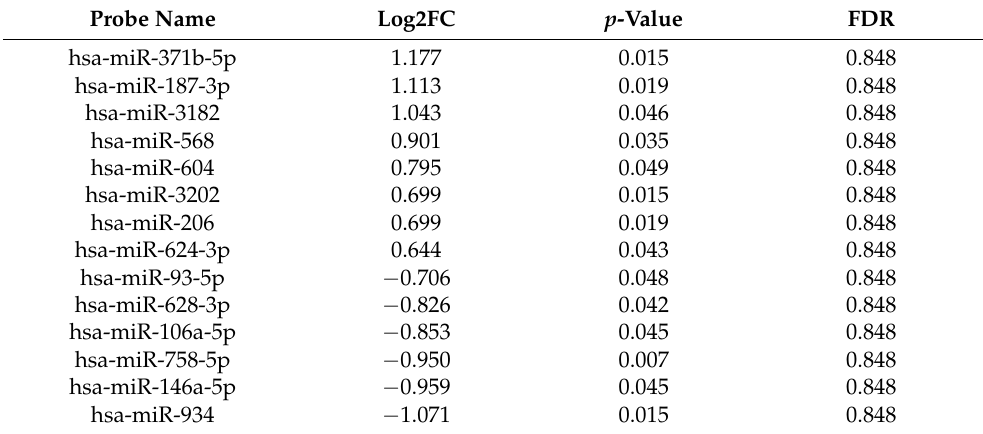
Figure 1. Volcano plot for differentially expressed microRNAs between experienced breacher vs. unexposed control. Green dots indicate genes that are upregulated, and purple dots indicate genes that are downregulated. Table 4. MicroRNA differential expression between experienced breacher vs unexposed control.